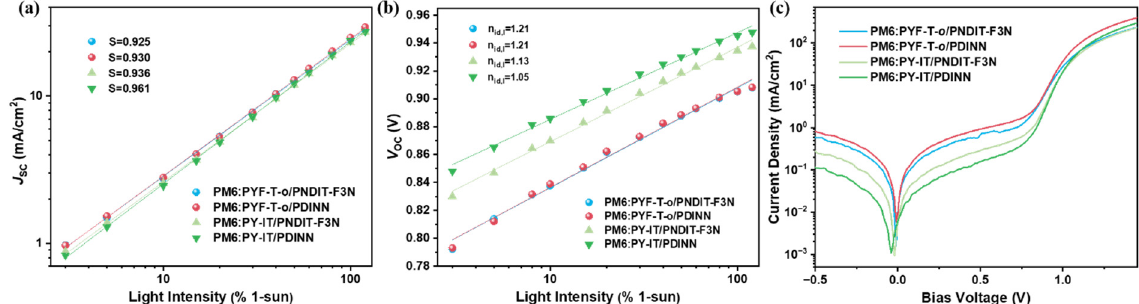
Figure 5. ( a , b ) are light intensity dependence of J SC and V OC of the OSCs based on PM6:PYF-T -o and PM6:PY-IT, respectively. ( c ) Dark J-V characteristics of the OSCs.